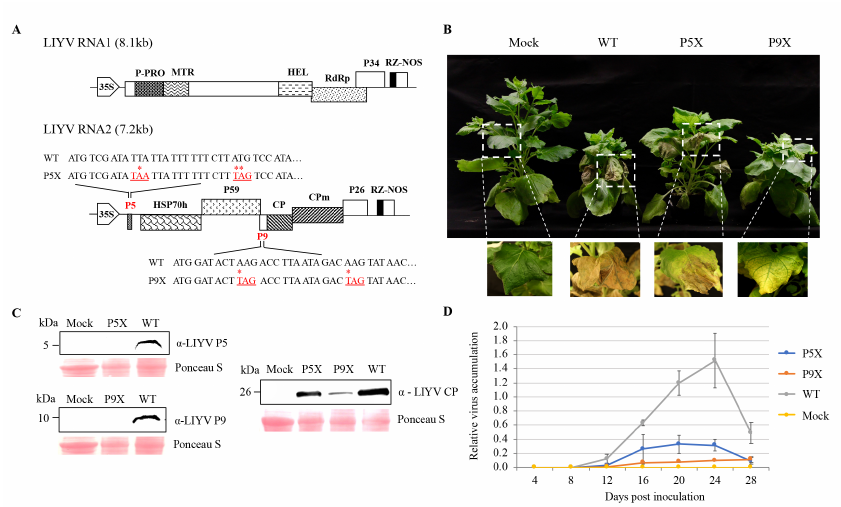
Figure 3. Mutational analysis of P5 and P9 functions in LIYV infection of Nicotiana benthamiana plants. ( A ) Schematic representation of the genomic organization of LIYV cDNA infectious clones. LIYV P5 and P9 knockout mutants (P5X, P9X) were constructed by introducing two in-frame stop codons near the 5 (cid:48) termini of the P5 and P9 ORFs of the LIYV wild-type (WT). The nucleotides replaced are marked with an asterisk (*) and addressed in red. NOS, nopaline synthase terminator; 35S, 35S promoter; the boxes indicate open reading frames (ORF) and their corresponding translation products. ( B ) N. benthamiana plants infected by LIYV WT, P5X and P9X photographed at four weeks